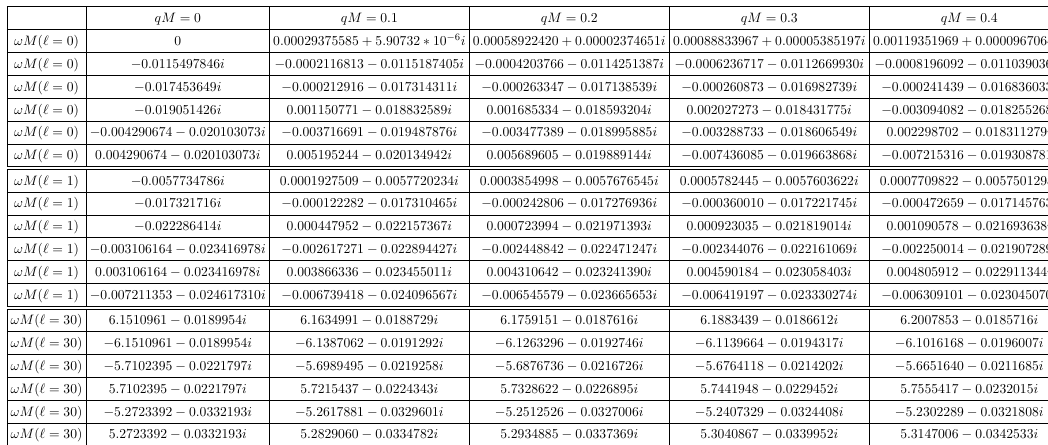
Table 5 . The QNFs ωM for massless scalar fields in the background of RNdS black holes with Λ M 2 = 10 − 4 , Q/M = 0 . 5 , and different values of ‘ , and qM .